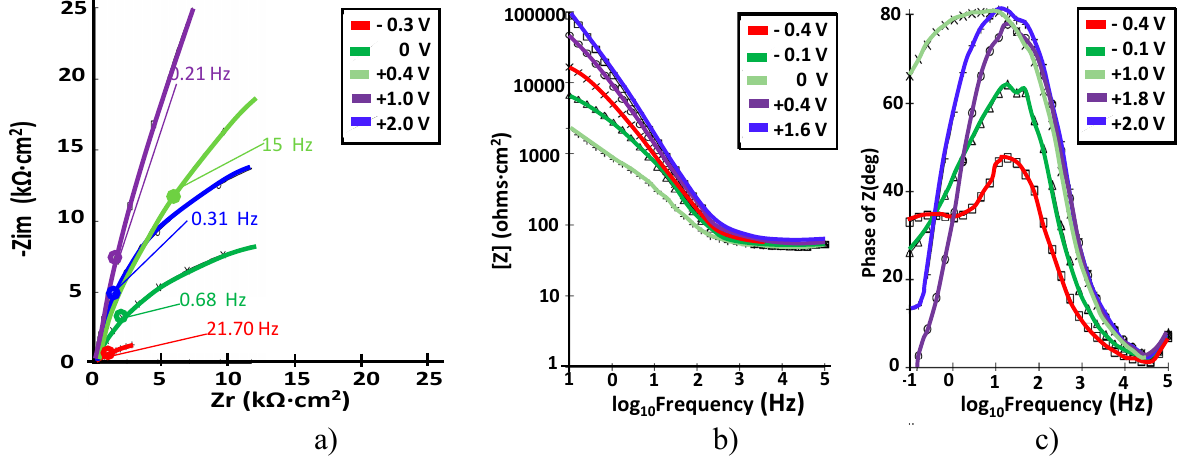
Figure 6. ( a ) Nyquist; ( b ) Bode –IZI and ( c ) Bode-phase spectra at different potentials for Ti–5Ta in simulated body fluid at pH = 7.8.